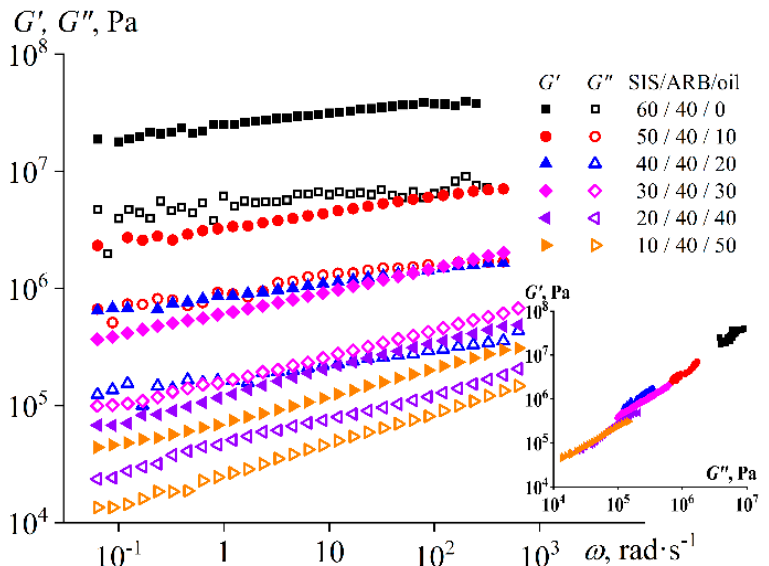
Figure 9. Frequency dependences of storage and loss moduli for triple mixtures containing the same concentration of asphaltene/resin blend (ARB) and different ratios between styrene-isoprene-styrene triblock copolymer (SIS) and naphthenic oil at 25 °C. The insert shows the Cole–Cole plots.